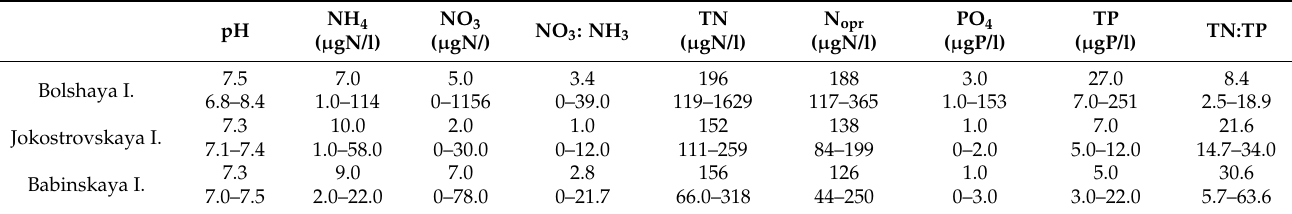
Figure 3. Annual average phosphorous load and critical phosphorous load baseline for Lake Iman- Table 2. Typical recent average values of the physicochemical characteristics of the surface water in various areas of Lake Imandra during the summer months. Numerator—median value; denominator—range of